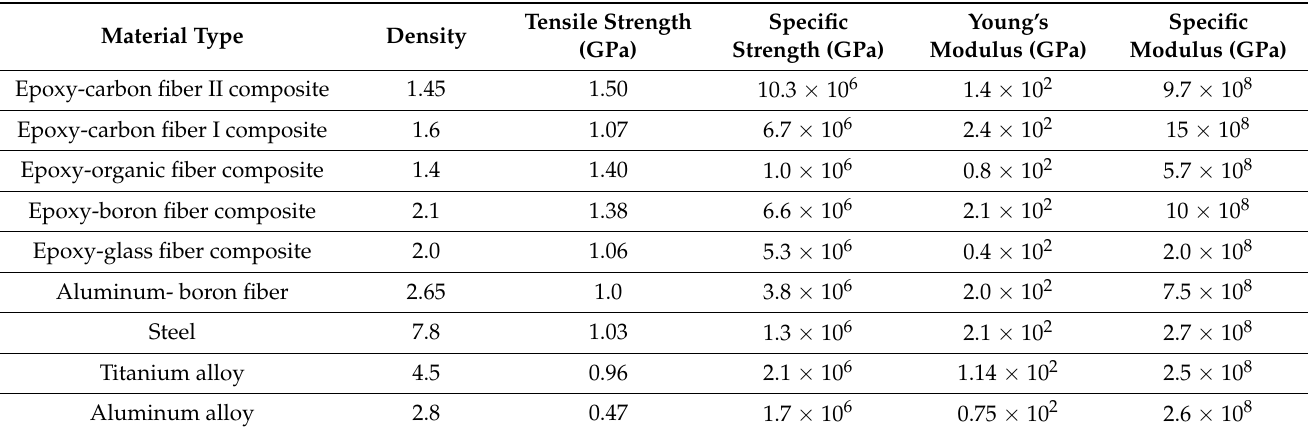
Table 4. Properties of materials with different structures